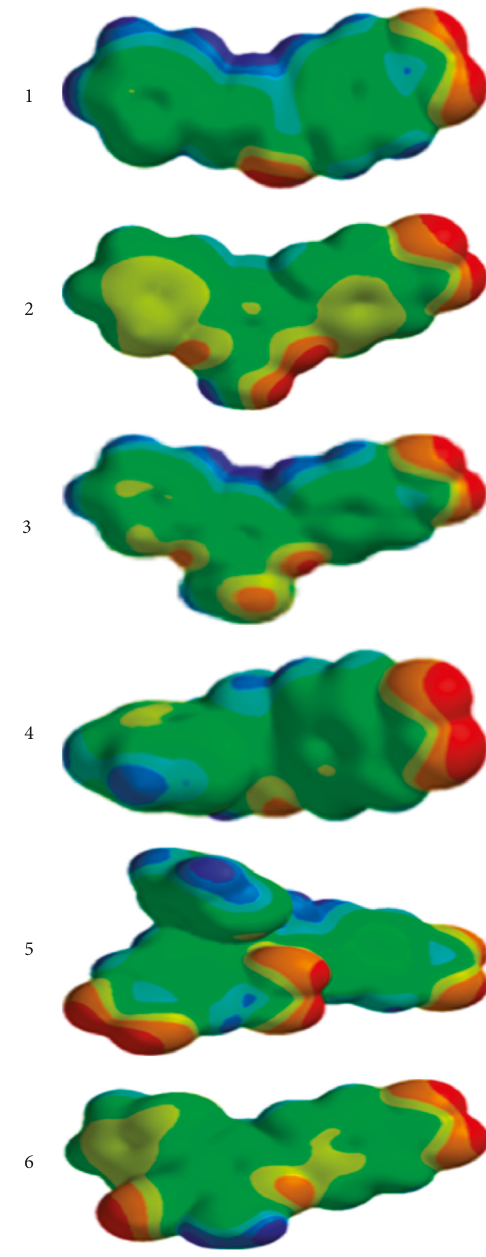
Figure 3: Solid surface (8 bands) of ESP maps and color codes. The color code reflects electrostatic potential energy values in kJ/mol. The redder the area is, the higher the electron density is susceptible to electrophilic attack and the bluer the area is, the lower the electron density is that could easily bind with a nucleophile. Table 2: Effect of the solvent on computed reactivity indices in eV sorted according to descending nucleophilicity in the gas phase. Gas Molecule